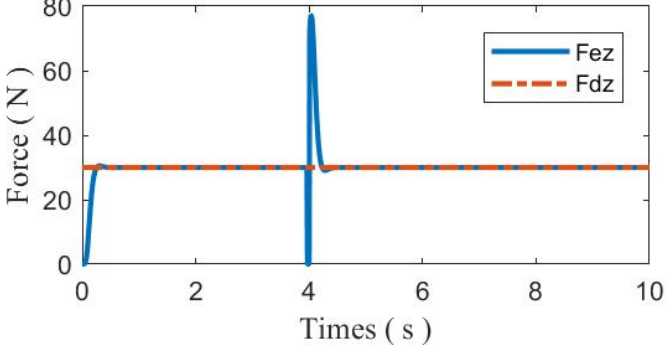
Figure 8. The process and result of optimization. ( a ) Convergence process. ( b ) The optimized configuration and flexibility ellipsoid.